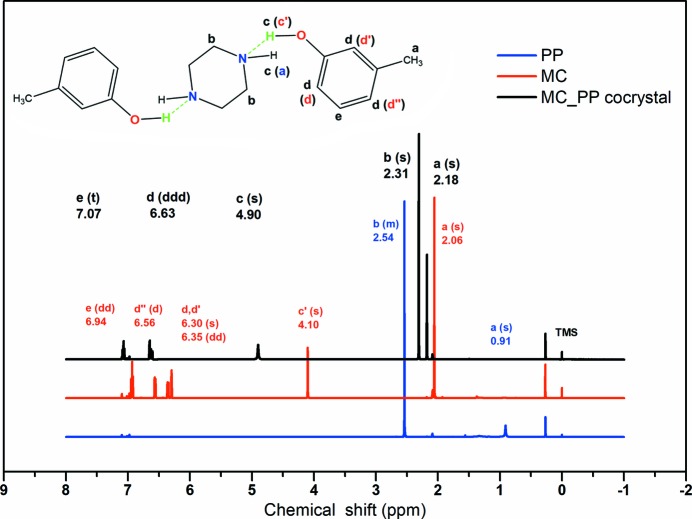

1H NMR spectra of MC_PP, MC and PP in toluene-d
8. 1H NMR (MC_PP, 500 MHz, toluene-d
8, 25°C, TMS): δ = 7.07 (t, 2 H; = CH-), 6.63 (ddd, 6 H; = CH-), 4.90 (s, 4 H; OH+NH), 2.31 (s, 8 H; CH2), 2.18 ppm (s, 6 H; CH3). 1H NMR (MC, 500 MHz, toluene-d
8, 25°C, TMS): δ = 6.94 (dd, 1 H; = CH-), 6.56 (d, 1 H; = CH-), 6.35 (dd, 1 H; = CH-), 6.30 (s, 1 H; = CH-), 4.10 (s, 1 H; OH), 2.06 ppm (s, 3 H; CH3). 1H NMR (PP, 500 MHz, toluene-d
8, 25°C, TMS): δ = 2.54 (m, 4 H; = CH2-), 0.91 (s, 1 H; NH).